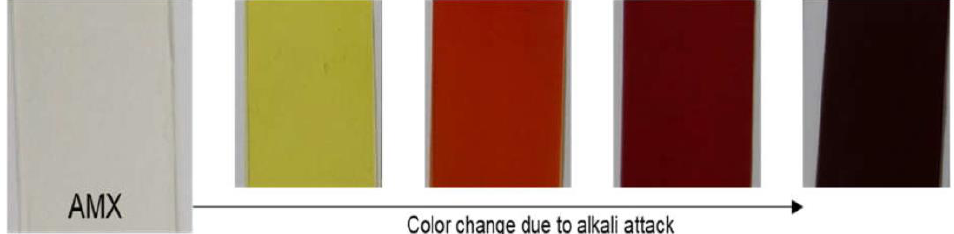
Figure 6. A color change trend of commercial AMX during the alkali immersion test. Reprinted